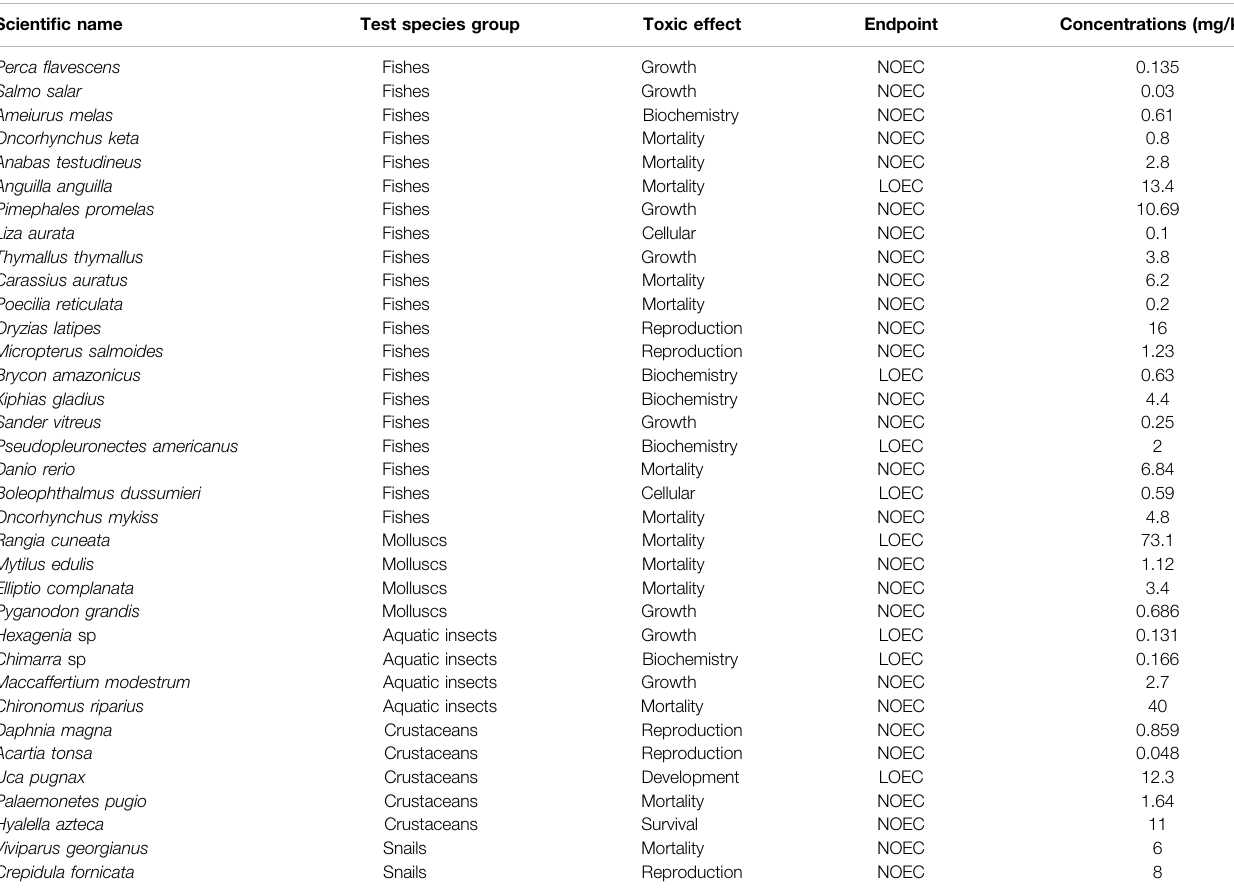
TABLE 2 | Toxic data of Hg on aquatic species-based